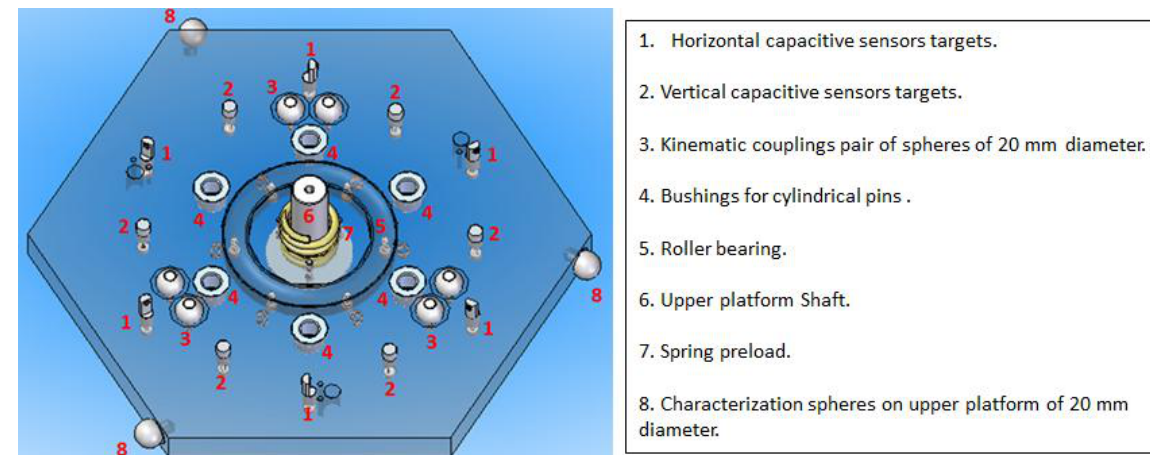
Figure 3. Mobile upper platform mechanical components.